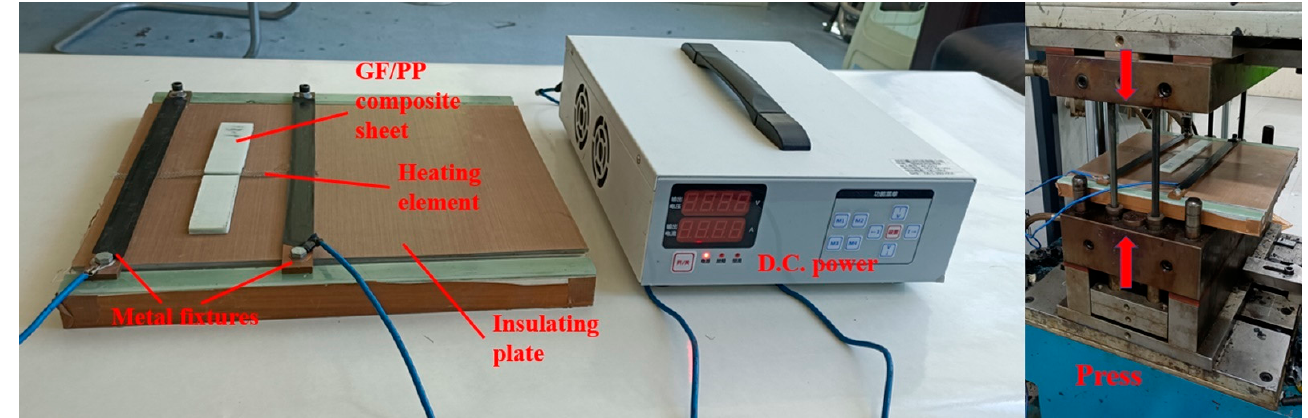
Figure 3. Schematic diagram of resistance welding device.